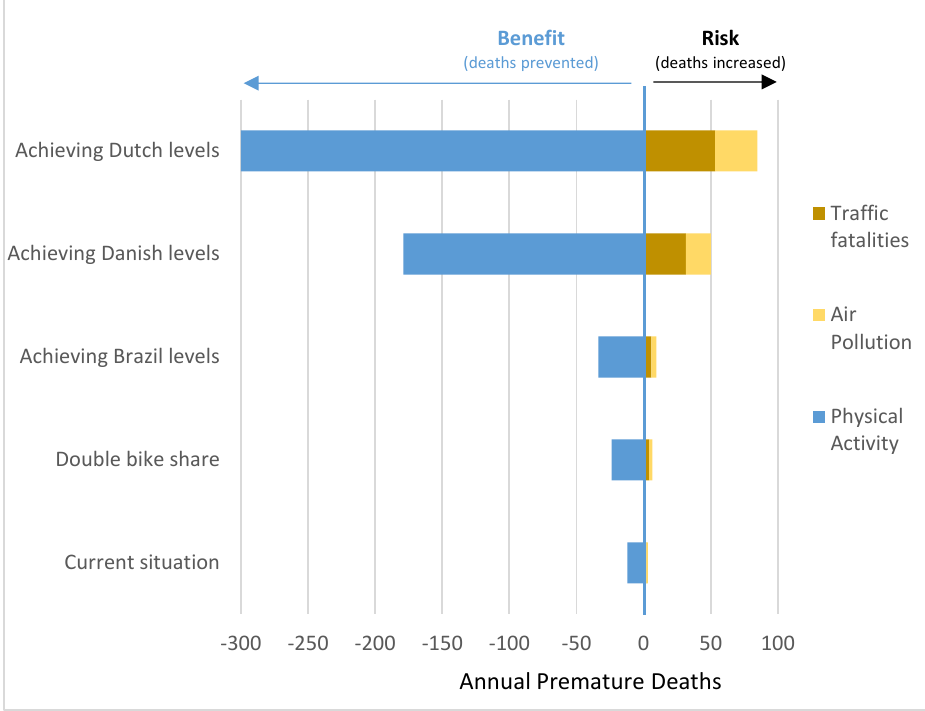
Figure 2. Risks and benefits of bicycling scenarios in Mexico, in annual premature deaths by scenario and risk factor.